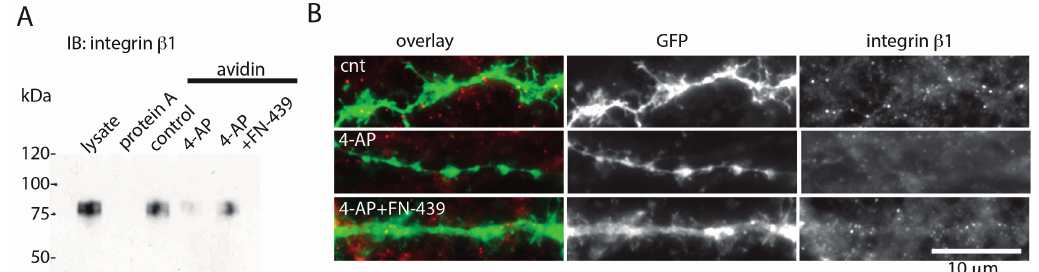
Figure 2. Surface expression of integrin β 1 decreases when neuronal activity is elevated. ( A ) Cell surface biotin-labeling analysis. Western blot analysis of integrin β 1. Lysate and protein A-sepharose (instead of avidin-conjugated sepharose) are used as positive and negative controls, respectively; and ( B ) Immunostaining against integrin β 1 in non-permeabilized GFP-expressing neurons. Neurons were treated for 18 h with 5 mM 4-AP with or without 50 μ M FN-439.